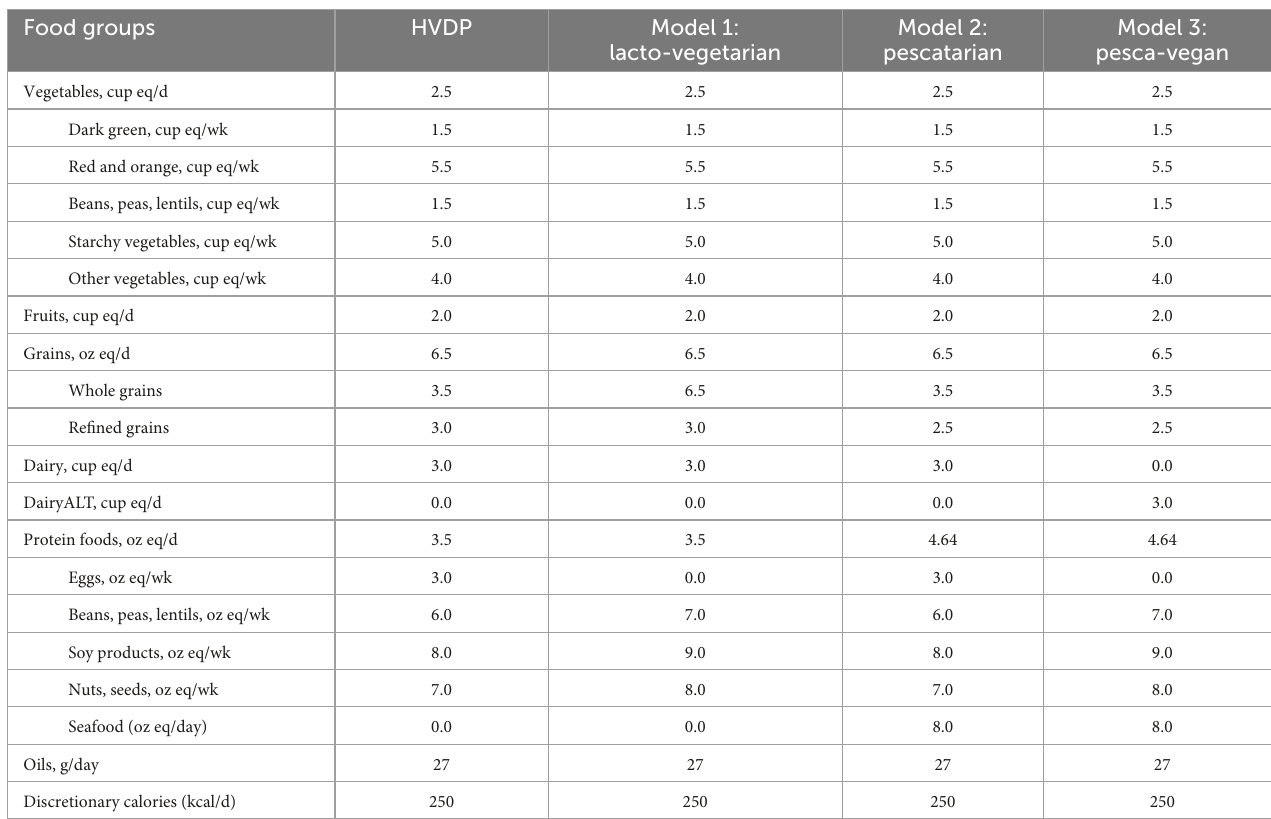
TABLE 2 From the 2020 Dietary Guidelines for Americans: daily or weekly amounts for each food group in the 2,000-kcal/d Healthy Vegetarian Dietary Pattern compared with the modeled dietary patterns 1 . Food